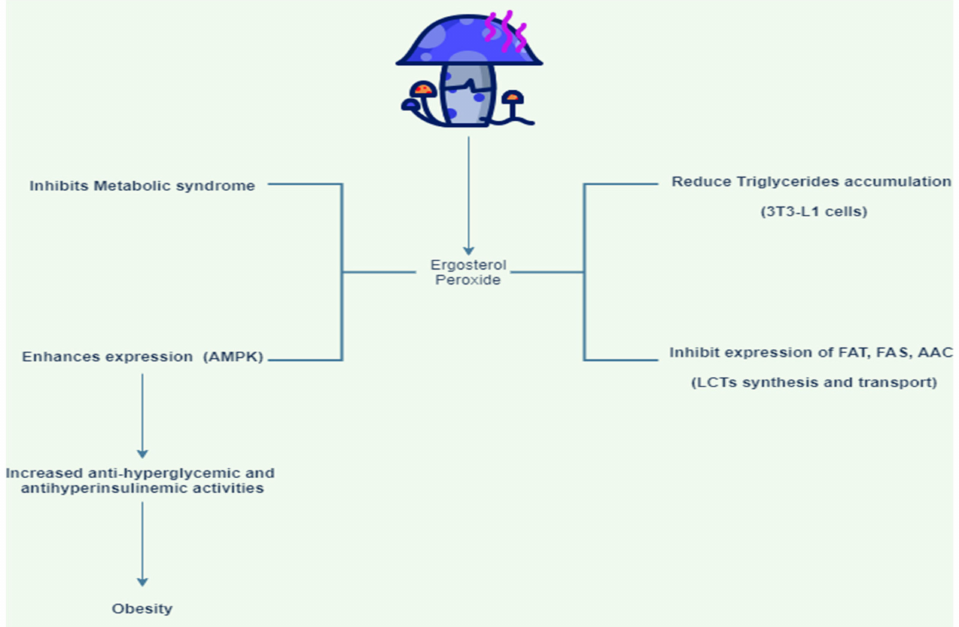
Figure 1. Pharmacological effects of ergosterol peroxide derived from mushrooms on obesity [38]. Ergosterol shows anti-obesity effect by reducing triglycerides accumulation, inhibiting expression of FAT, FAS, AAC, inhibiting metabolic syndrome, enhancing AMPK expression, increasing antihyper- glycemic, and anti-hyperinsulinemic